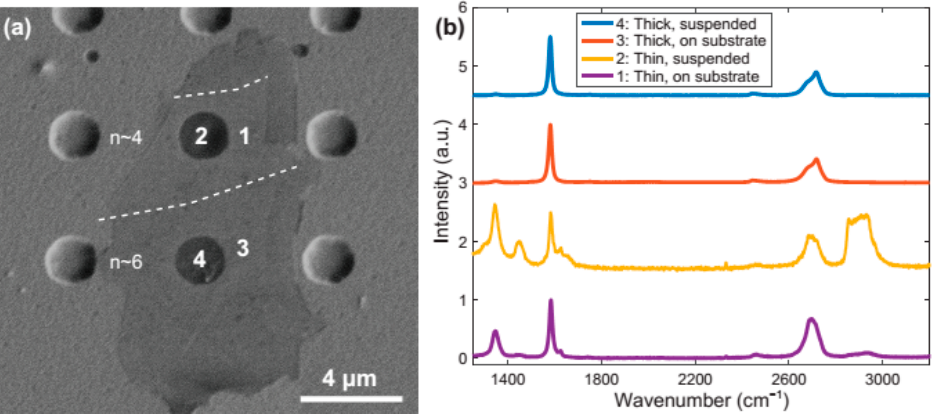
Figure 1. ( a ) SEM image and ( b ) Raman spectra of ‘thin’ and ‘thick’ regions of the graphene attached to the SiO 2 /Si substrate (locations 1 and 3, respectively) and suspended regions (locations 2 and 4). All spectra are normalized by the G-intensity. Dashed lines on the SEM image indicate the boundary between different thicknesses for clarity. Table 1. Values of G and 2D band positions of thin and thick graphene layers.